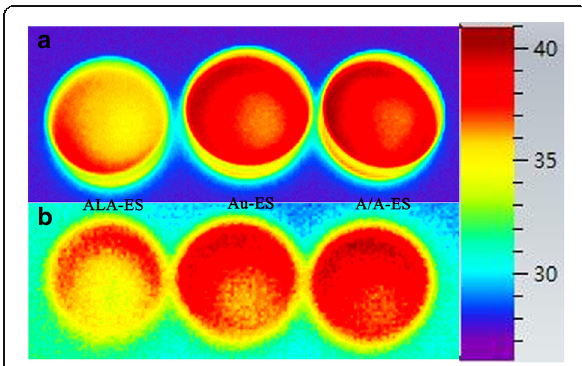
Fig. 5 . Infrared microscopic imaging of HSF treated with ALA-ES, Au-ES, and A/A-ES for 6 h under ( a ) and after irradiation ( b